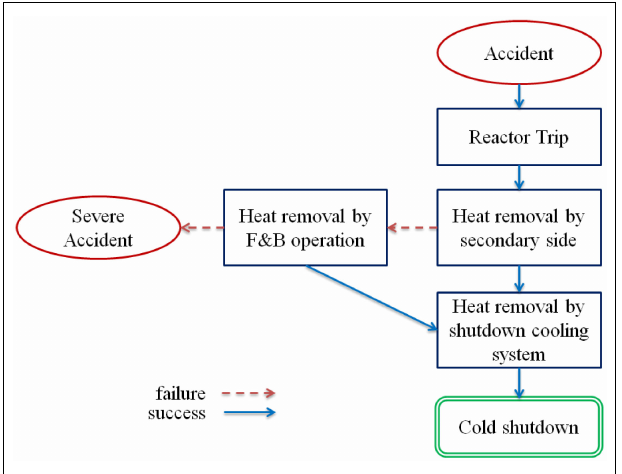
FIGURE 2 | Process of safety shutdown in OPR-1000